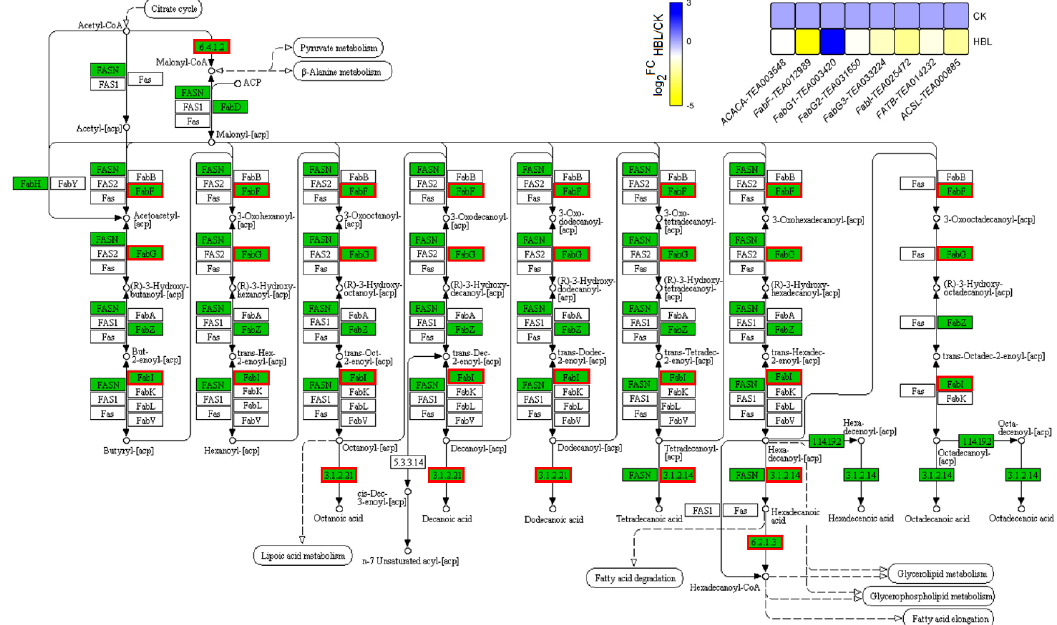
Figure 7. DEGs involved in fatty acid biosynthesis under high-intensity blue light in tea plant shoots. In the pathway adapted from KEGG, the green box indicates the background genes of tea plant genome, and the red line indicates the annotated DEGs. The heatmap was generated from the log 2 -fold change (log 2 FC) mean value calculated from three replicates of RNA-Seq data.